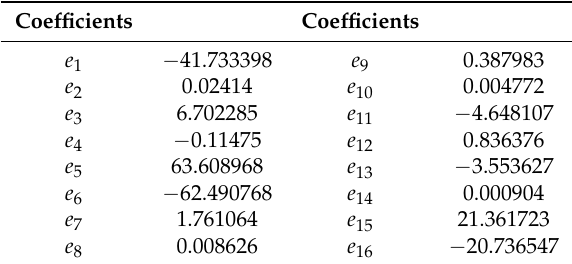
Table 4. Coefficients for Equation